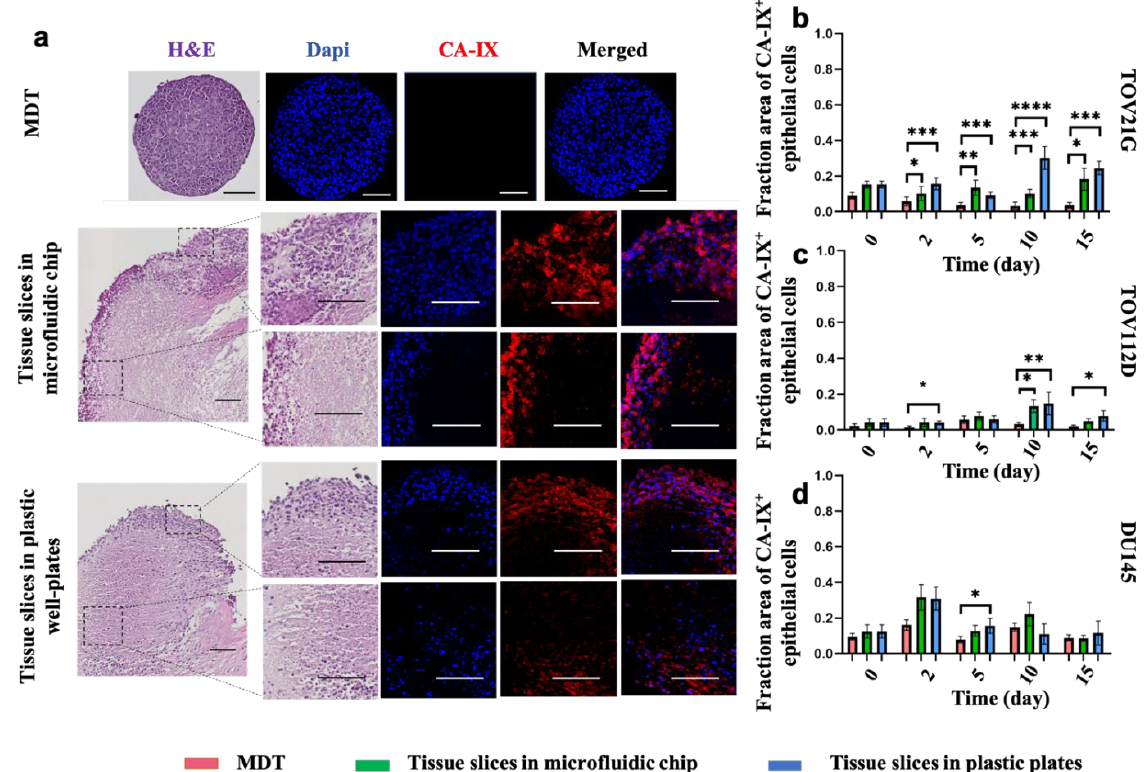
Figure 4. Incidence of hypoxia and necrosis in tumor models over a 15-day culture period using ovarian (TOV21G and TOC112D) and prostate (DU145) cancer cell line xenografts. ( a ) Representative images of tumor models produced from TOV21G after 10 days in culture stained with H&E or following IF with Dapi and CA-IX. H&E staining showed high levels of necrosis in tissue slices. b, c, and d IF scoring of tumor models of showed higher CA-IX expression over the 15-day period in tissue slices compared to MDTs. Results show increasing CA-IX expression until day 10 of culture in tissue slices for TOV21G ( b ), TOV112D ( c ), and DU145 ( d ) xenograft tumor models. Scale bars = 100 μm. Error bars = ± SEM. * p < 0.05; ** p < 0.01; *** p < 0.0001; **** p < 0.00001.